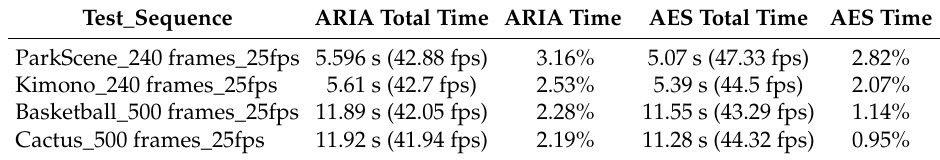
Table 8. Processing time comparison between ARIA and AES